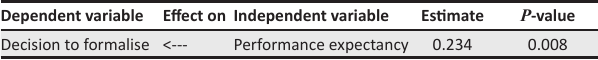
TABLE 2: Performance expectancy and decision to formalise human resource